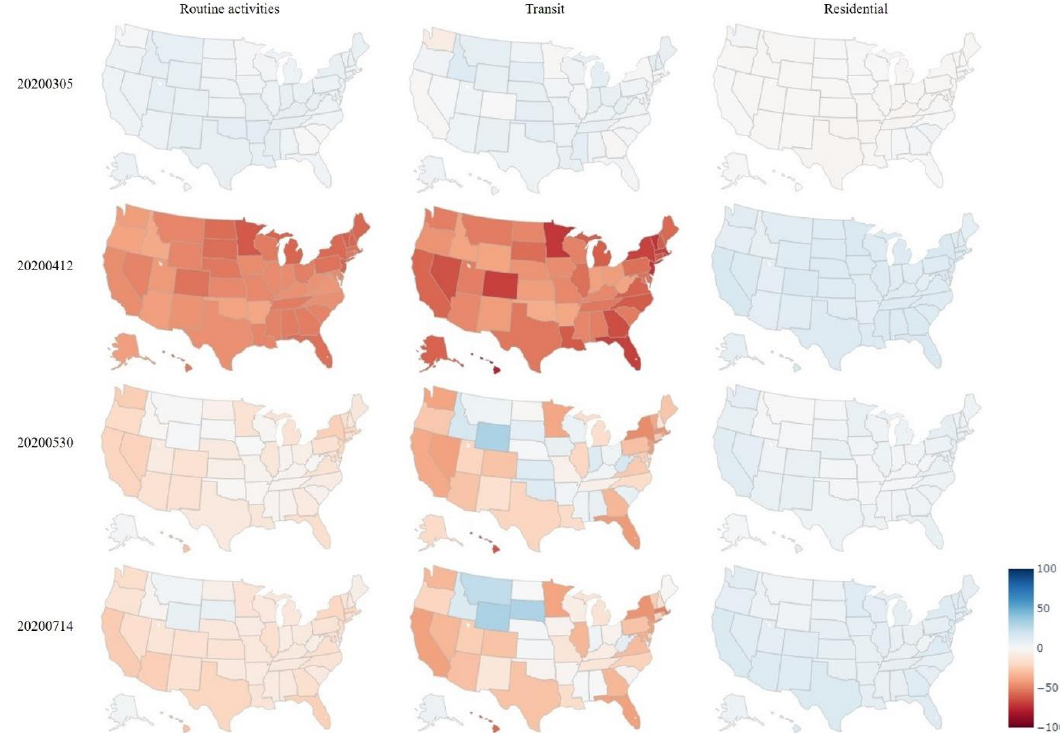
Figure A2. Community mobility changes during the epidemic of COVID-19 across the US.